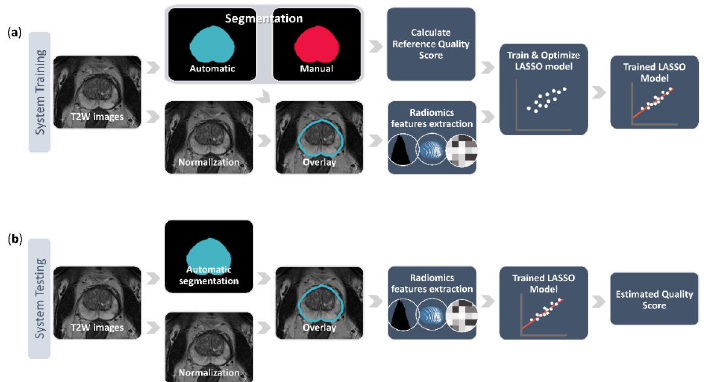
Figure 1. The pipeline of training ( a ) and testing ( b ) the proposed quality control system. The system